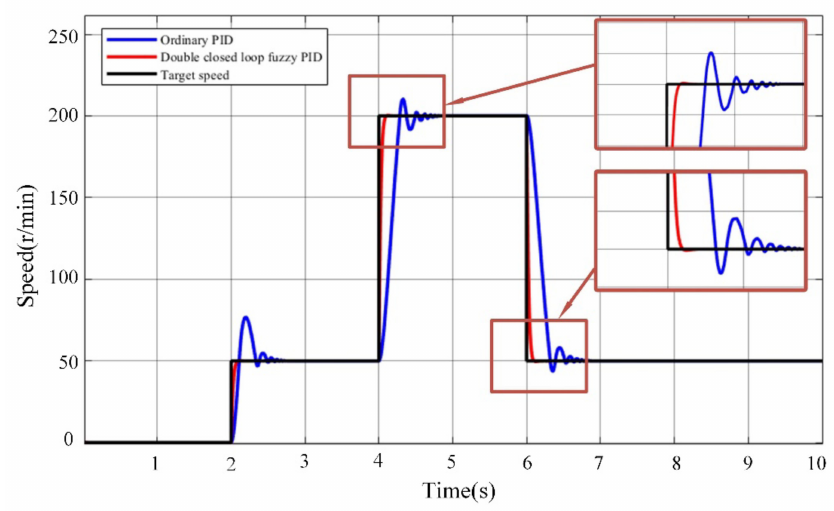
Figure 9. PWM input waveform diagram.